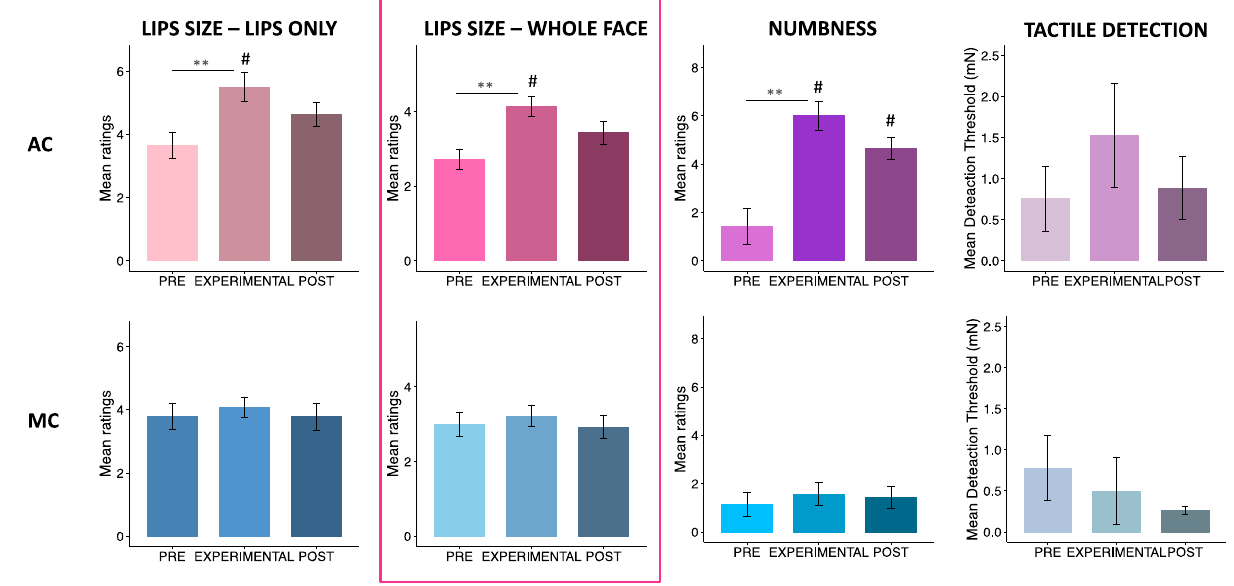
Figure 5. Mean rating scores for the lips size (lips only and whole face ratings), numbness and tactile detection across time points (PRE, EXPERIMENTAL, POST) of Experiment 3 for the AC (top panel) and MOIST (bottom panel). The error bars indicate the standard error of the mean. ** p < 0.01; *** p < 0.005, **** p < 0.001 in the difference between time points; # p < 0.01 in the difference between conditions (AC and MOIST). The pink panel indicates the lip-size measure entered in the LMM analysis in the main manuscript. Results of LMM using the other lip measure are reported in the Supplementary